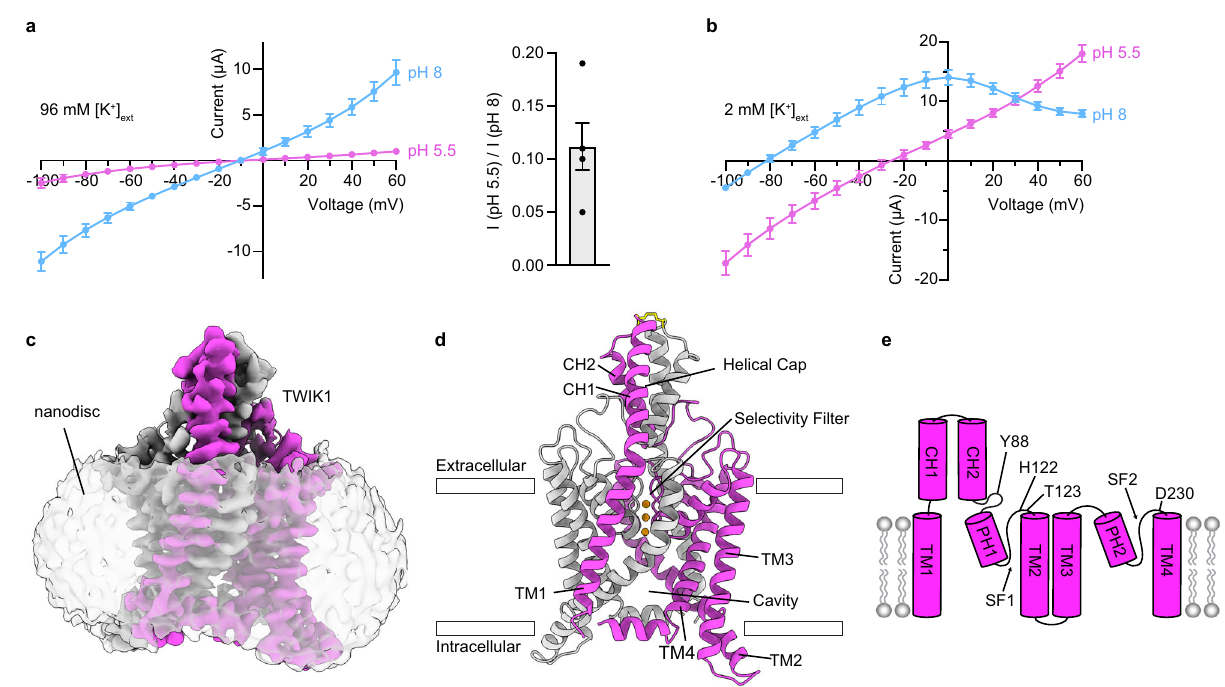
Fig. 1 Structure and function of TWIK1. a , b Current-voltage relationships from TWIK1-expressing cells at high and low pH ext in ( a ) high [K + ] ext and ( b ) low [K + ] ext . a , ((right) Fraction of current remaining after extracellular acidi fi cation in high [K + ] ext (I pH 5.5 /I pH 8 at 60 mV = 0.11 ± 0.03, mean ± sem from n = 4 and 6 cells for high [K + ] ext and low [K + ] ext , respectively. c Cryo-EM map at pH 5.5 viewed from the membrane plane. Nanodisc is transparent and TWIK1 subunits are magenta and white. d TWIK1 model colored as in c with K + ions orange and disul fi de yellow. e Cartoon representation of a TWIK1 protomer with four transmembrane helices (TM1-TM4), two extracellular cap helices (CH1-CH2), two-pore helices (PH1 – PH2), two selectivity fi lters (SF1 – SF2), and key residues involved in extracellular pH-gating indicated. Source data for a , b are provided as a Source Data fi